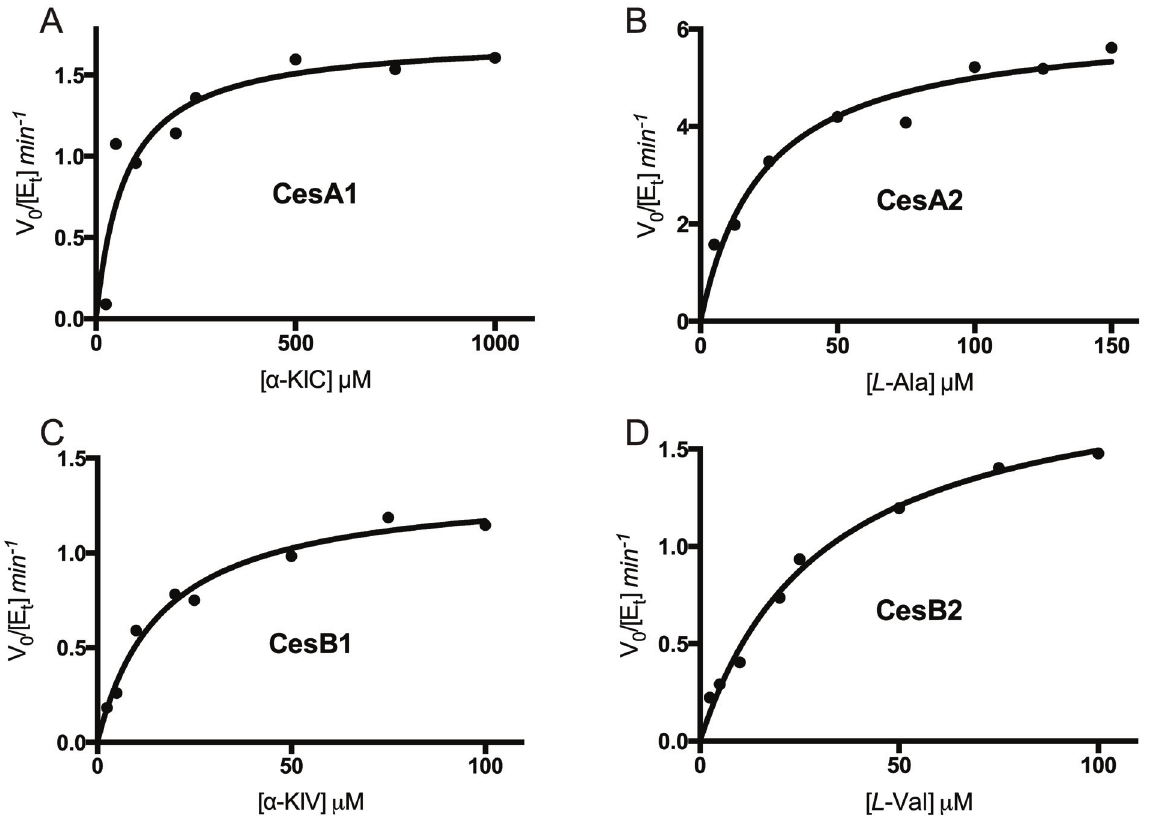
Fig 3. Kinetic characterization of adenylation by A domains using the pyrophosphate production assay. Initial velocity versus substrate concentration plots for adenylation of cognate substrates for CesA1 (A), CesA2 (B), CesB1 (C) and CesB2 (D). Curves were fit to the Michaelis-Menten equation. The kinetic parameters obtained are listed in Table 1.